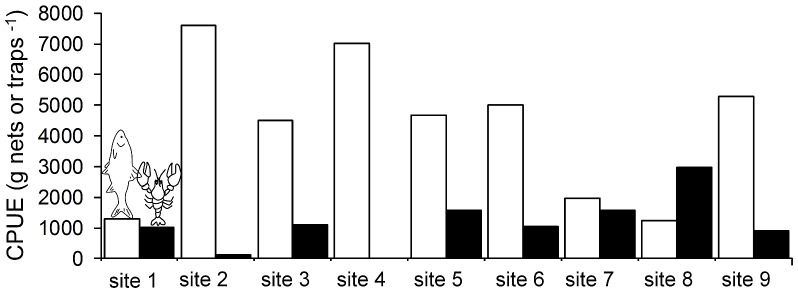
Predators of zebra mussels differ locally in their density.Density of roach (white bars, fish symbol) and crayfish (black bars, crayfish symbol) at the sampled sites expressed as catch per unit effort (four Nordic gill-nets in the case of roach and 20 baited traps in the case of crayfish). Note that crayfish from site 4 were lost after catch.